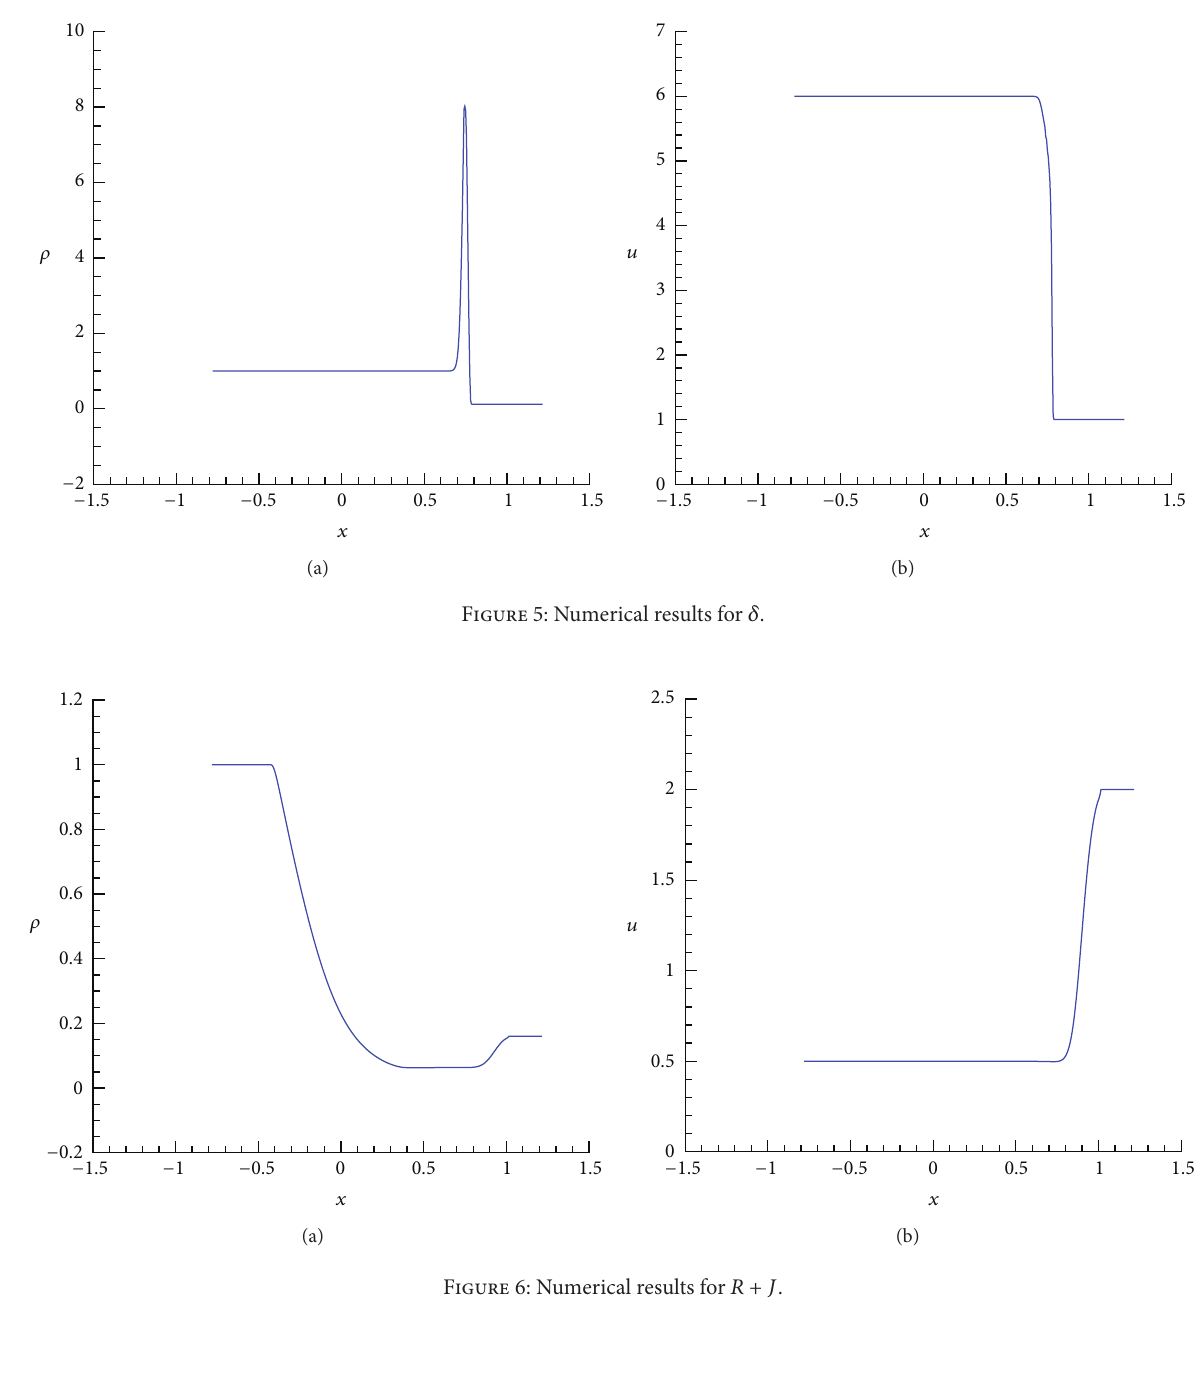
Figure 5: Numerical results for 𝛿 .